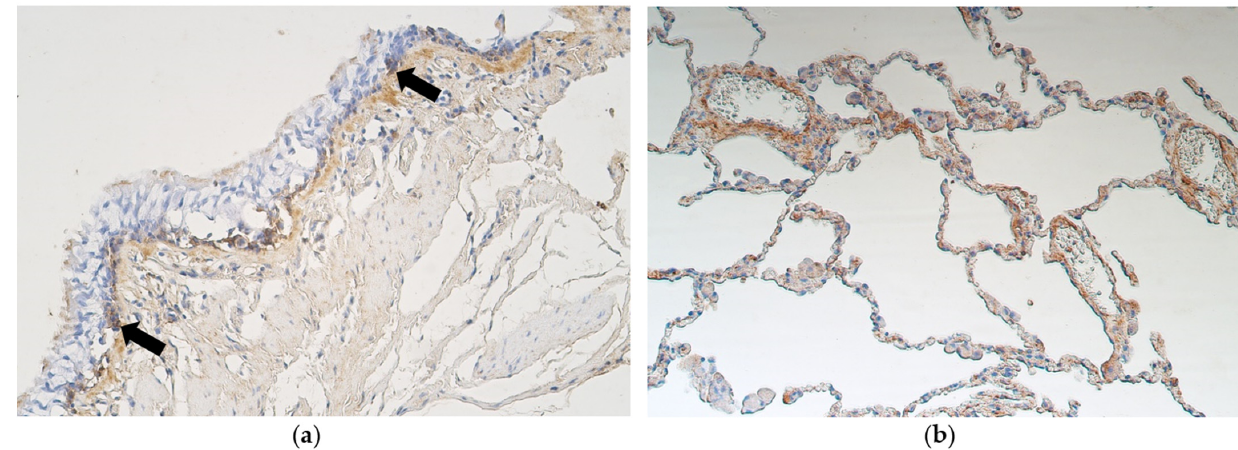
Figure 5. ( a ) Occasional VEGF-positive cells (arrows) are seen in non-changed bronchial epithelium